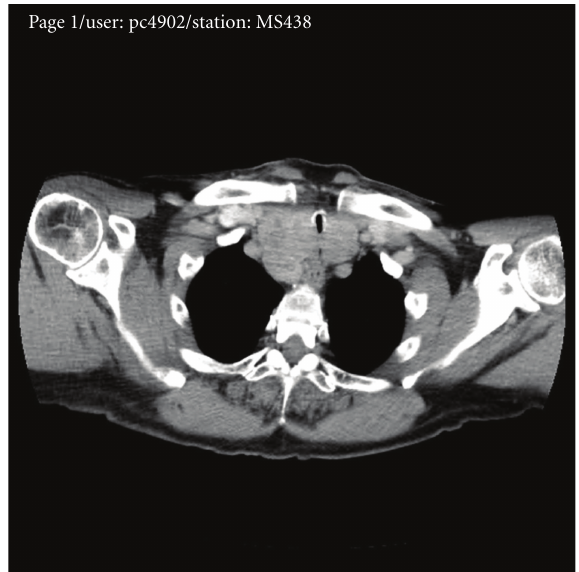
Figure 2: CT scan showing the retrosternal goitre compressing the